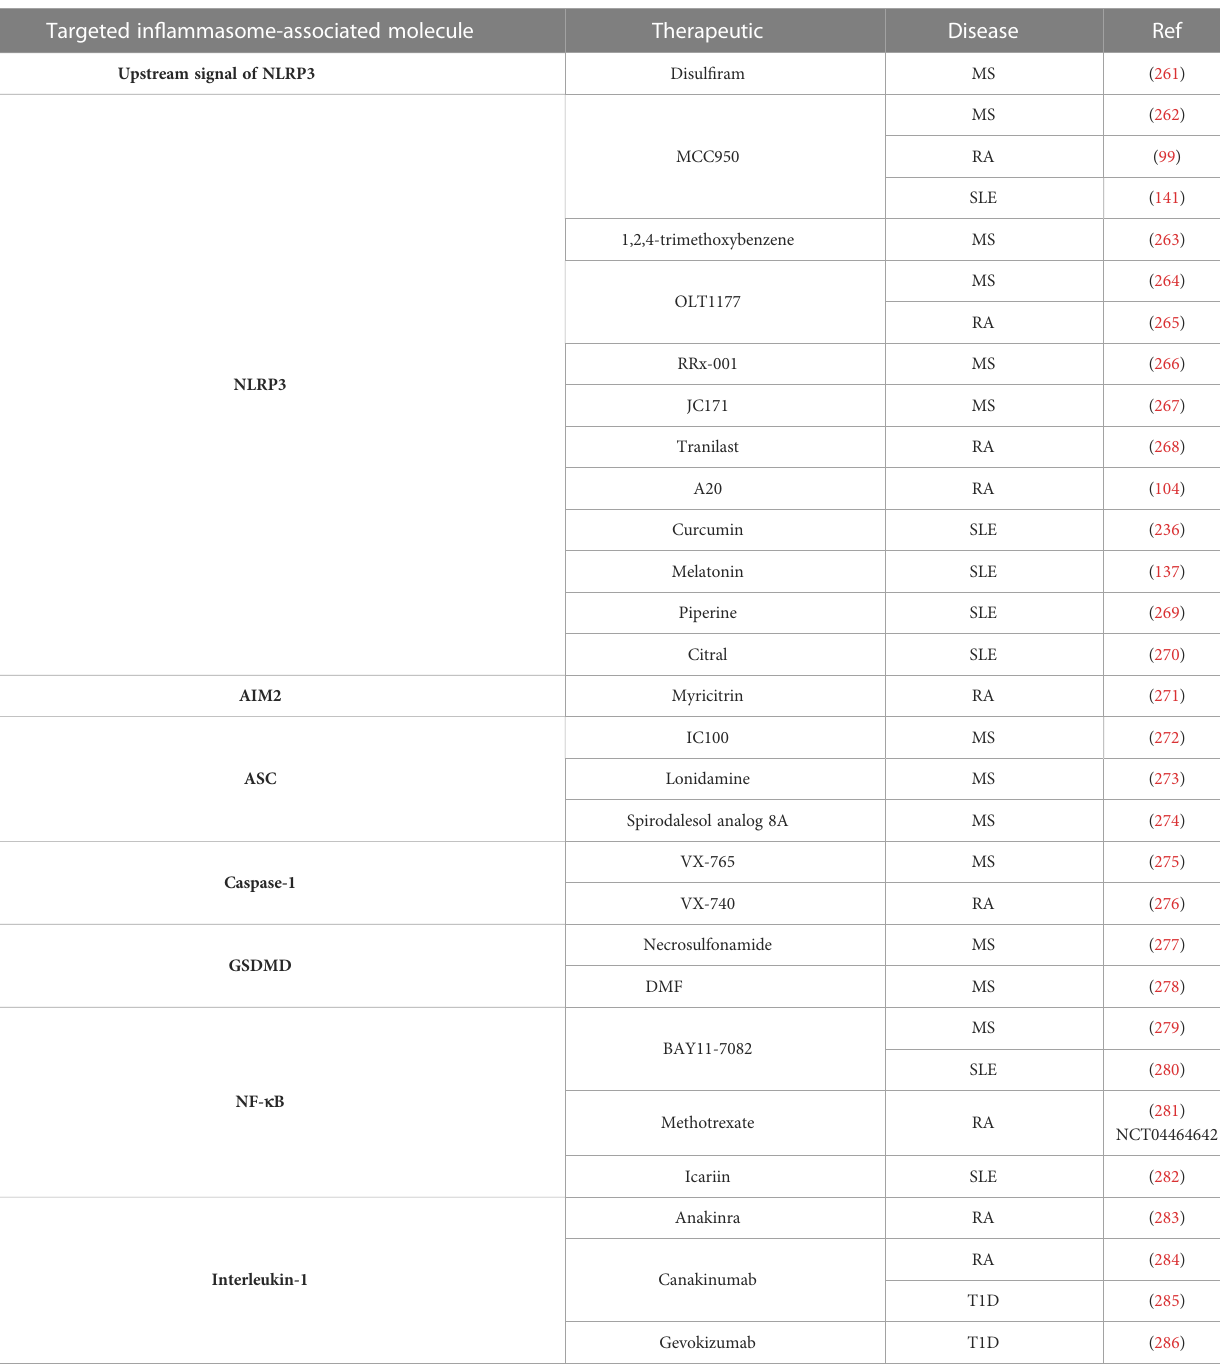
TABLE 3 Therapeutic strategies targeting in fl ammasomes for autoimmunity. Targeted in fl ammasome-associated